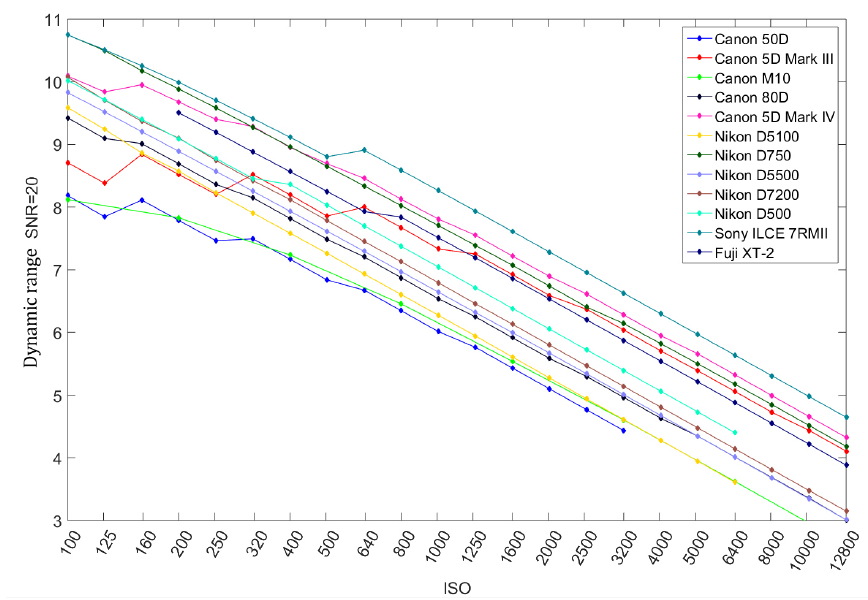
Figure 17. Photographic dynamic range vs. ISO for SNR = 20 and circle of confusion C = 25 µ m (full frame).